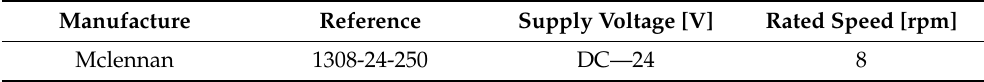
Table 4. Characteristics of the document height adjustment motor.